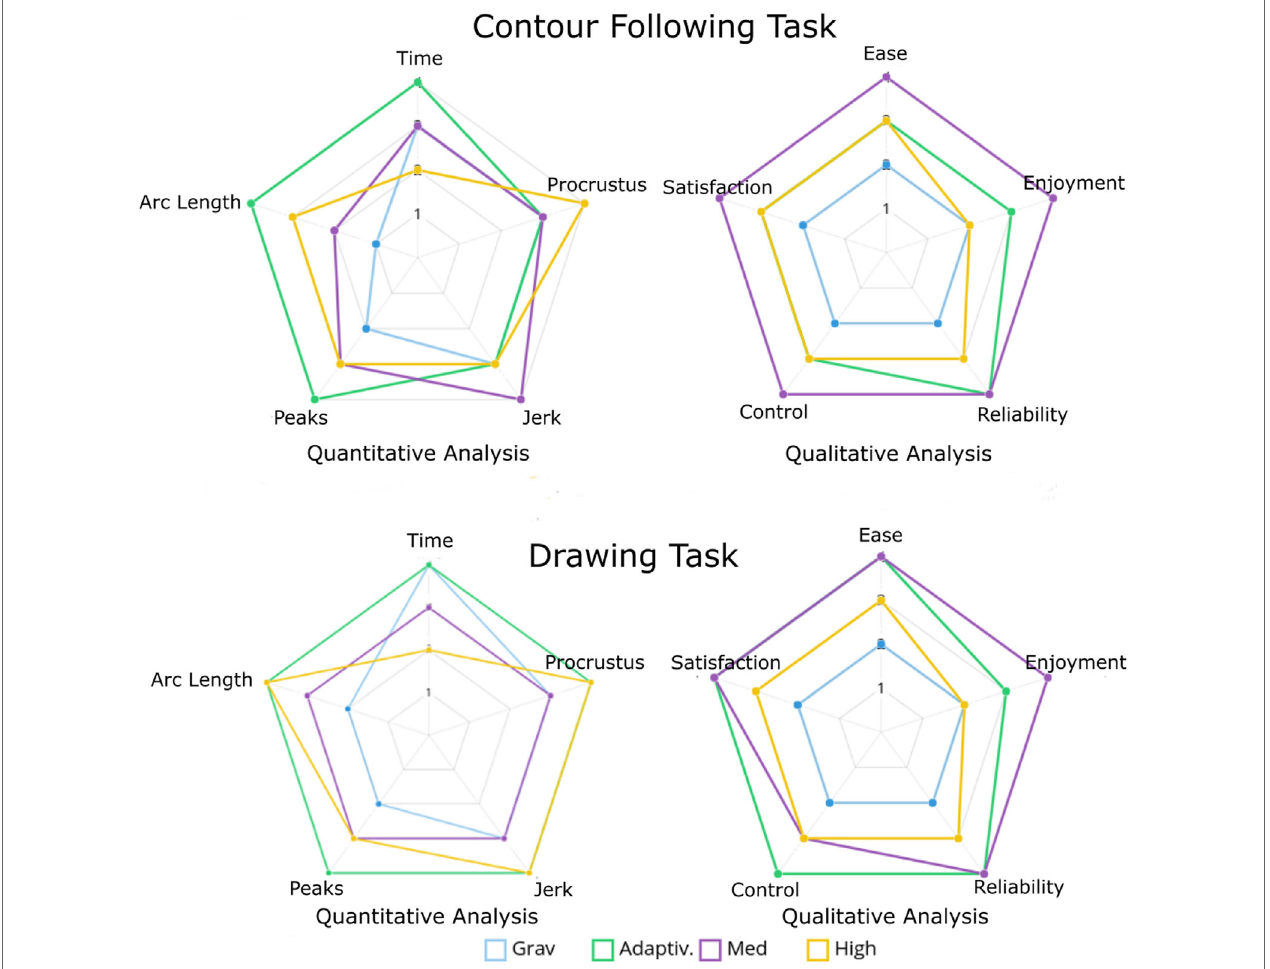
FigUre 11 | Radar charts showing the ranking of the control modes for each performance criterion for both tasks depending on their statistical